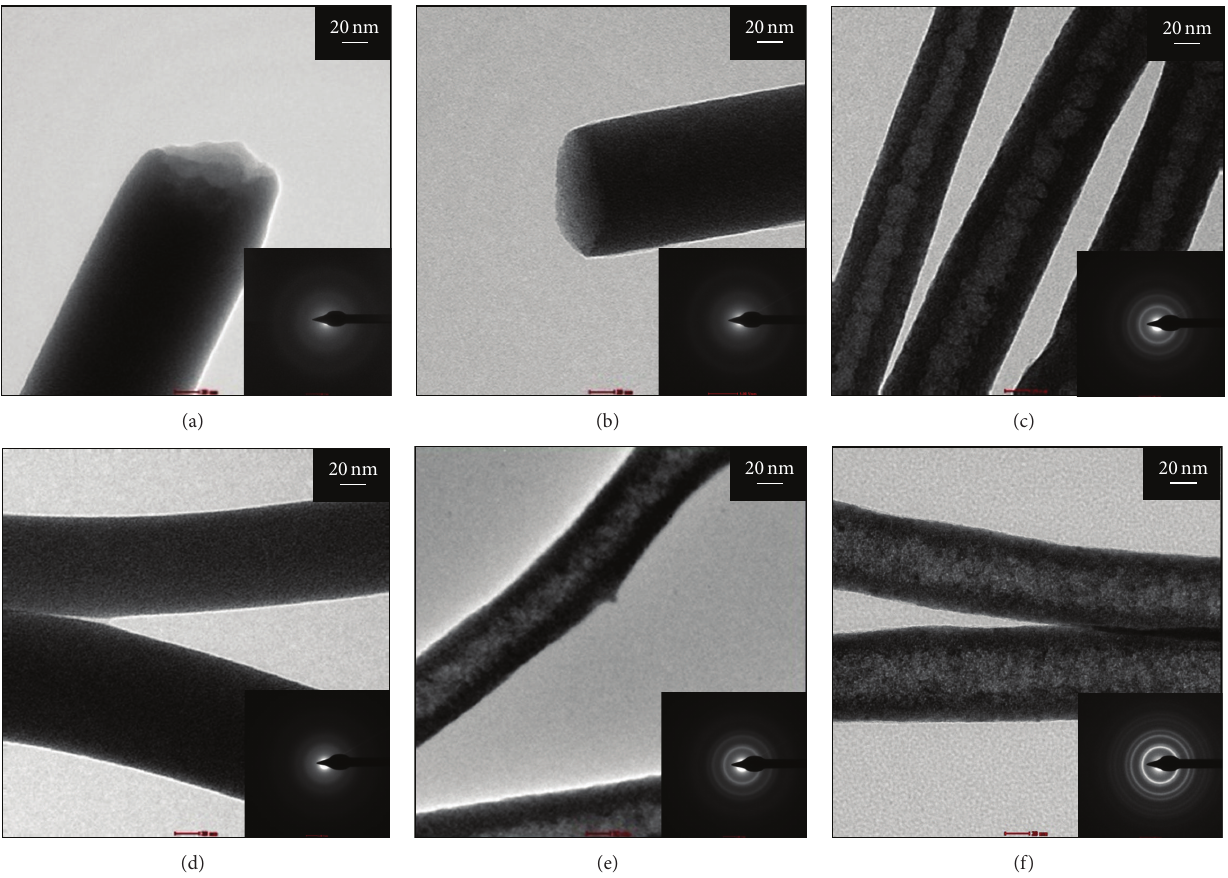
Figure 4: TEM bright field images of GDC20 nanofibers for (a) as-spun sample and those heated at (b) 250 ∘ C 3 h, (c) 250 ∘ C 5 h, (d) 275 ∘ C 1h, (e) 275 ∘ C 3 h, and (f) 300 ∘ C 1h in air and their associated selected area electron diffraction (SAED) patterns: